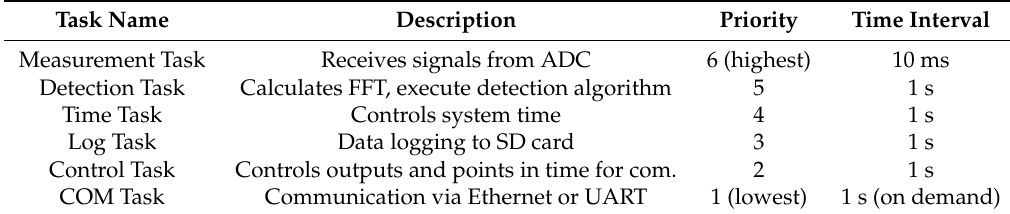
Table 1. FreeRTOS